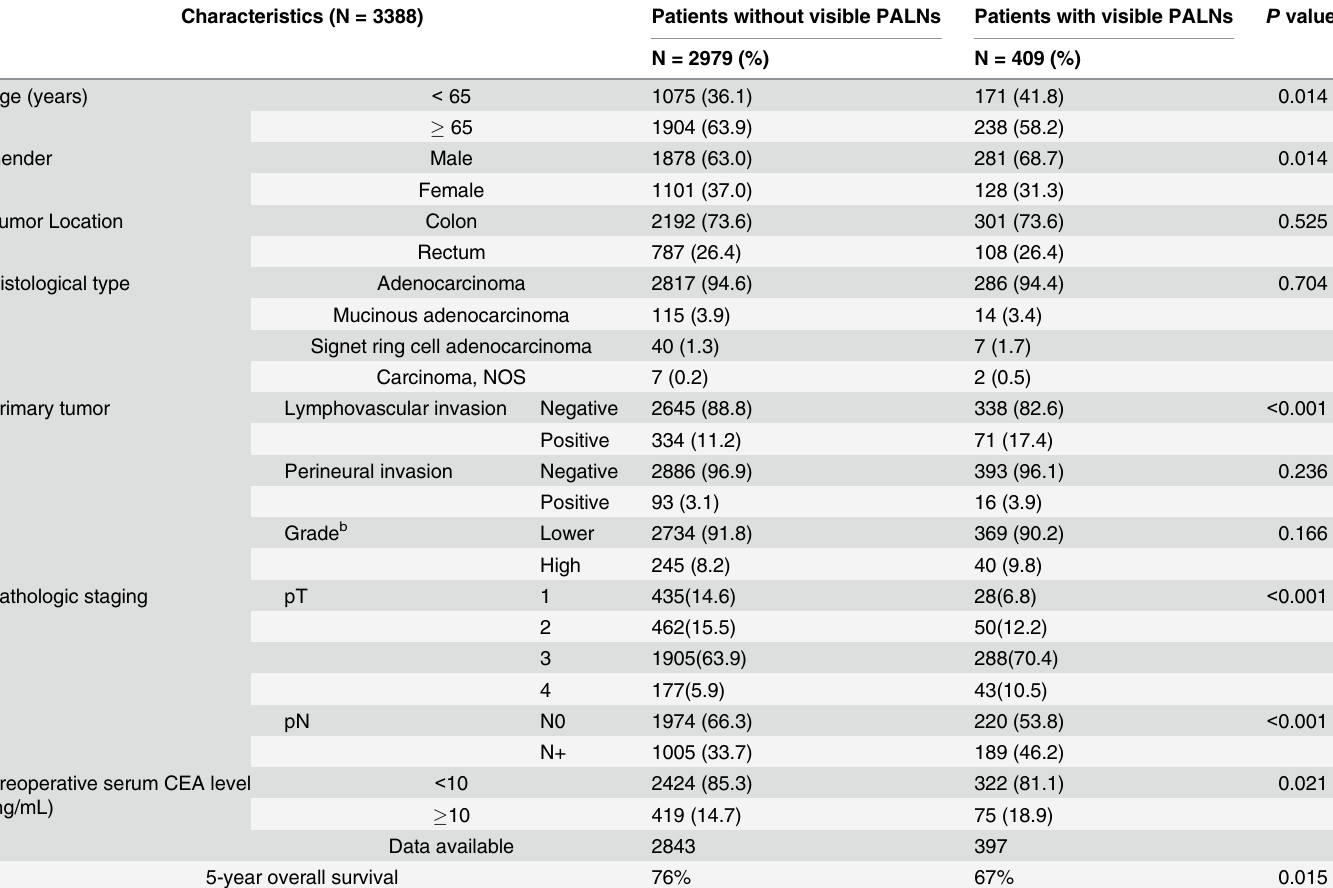
Table 1. Characteristics of patients with or without visible PALNs a